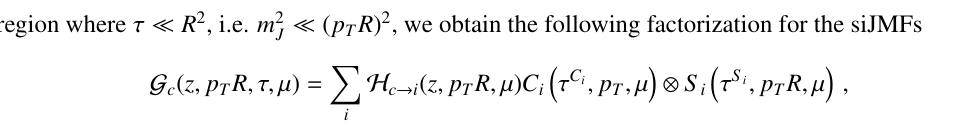
R 2 , i.e. m 2 region where τ ( p T R ) 2 , we obtain the following factorization for the siJMFs J (cid:30) (cid:30)